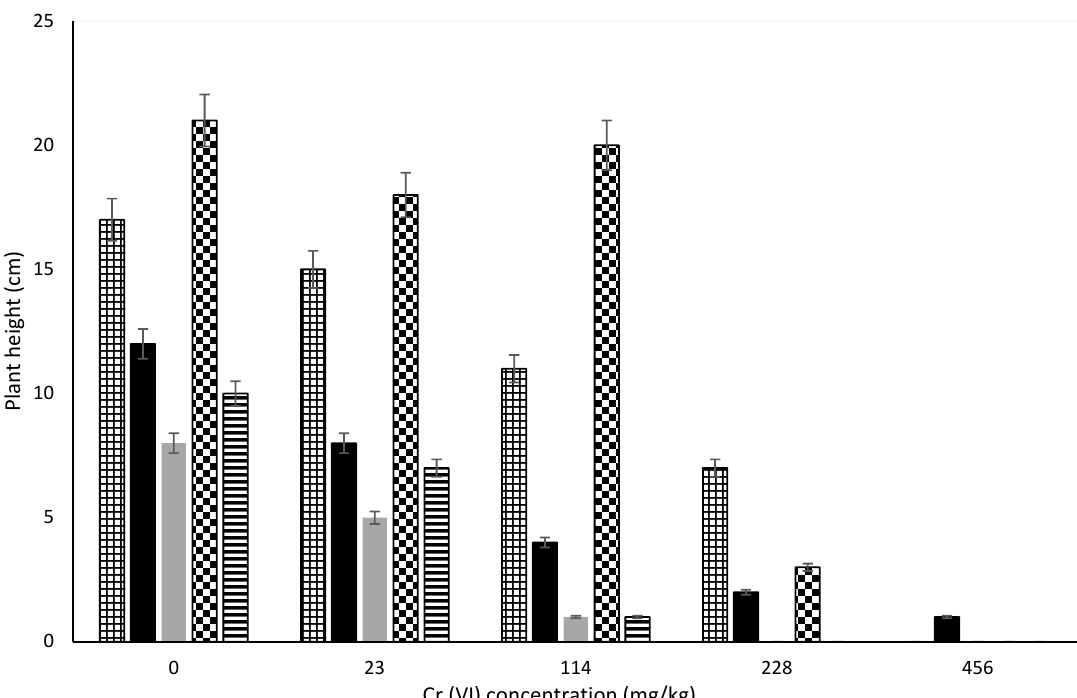
Figure 2. E ff ect of Cr(VI) concentration on di ff erent plant heights in simulated soil. (n = 3, SD). SD: Figure 2. Effect of Cr(VI) concentration on different plant heights in simulated soil. (n = 3, SD). SD: standard deviation. standard